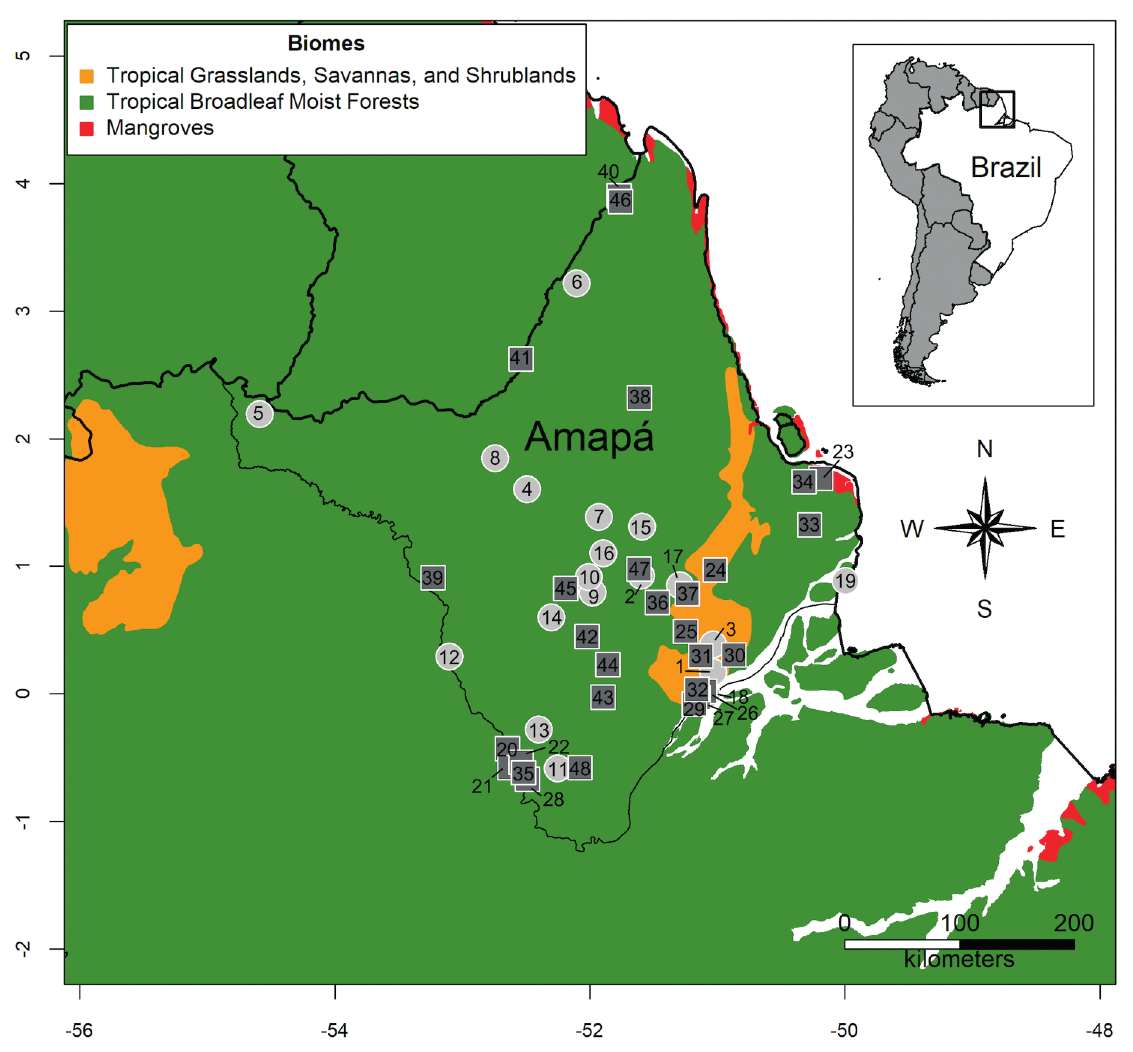
Fig. 10. Localities showing distribution records of anuran species through the biomes within the state of Amapá. Localities 1 to 19 are from species checklists (light gray circles), whereas the remaining ones (20 to 48, dark gray squares) represent punctual